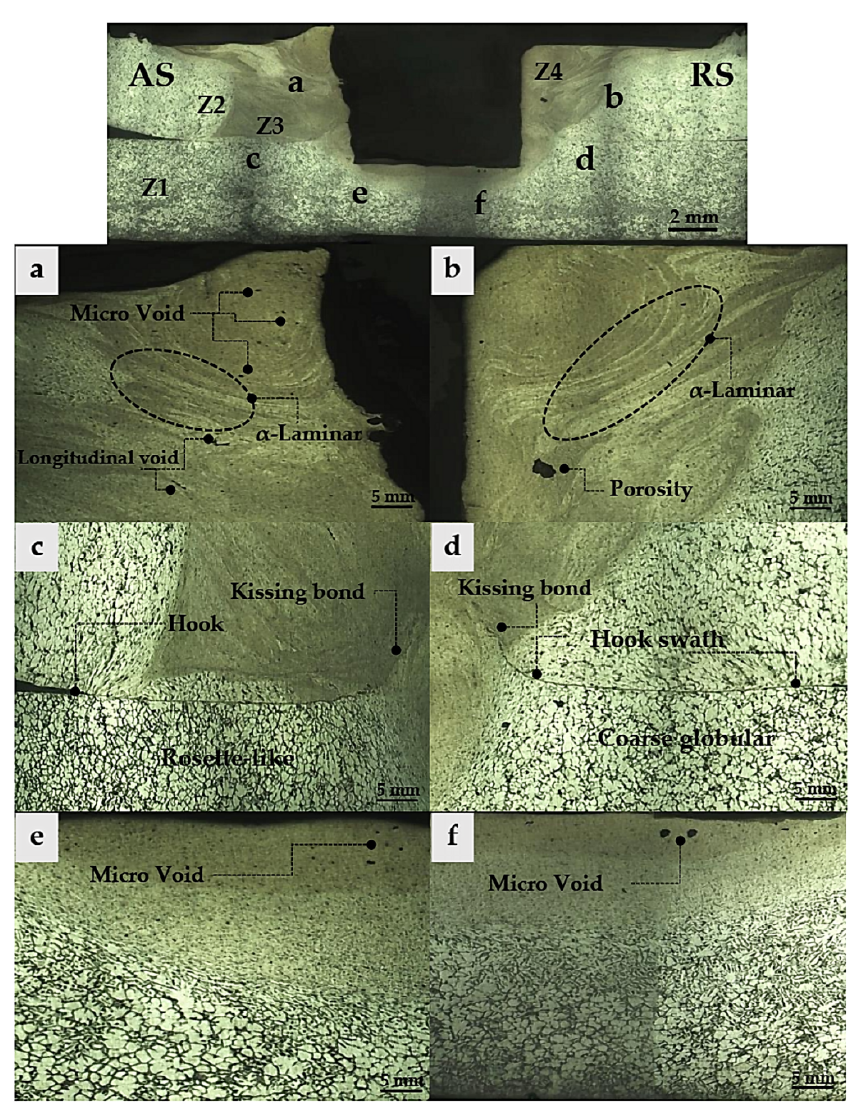
Figure 9. Micrographs of the cross-section of NZ from recrystallization by